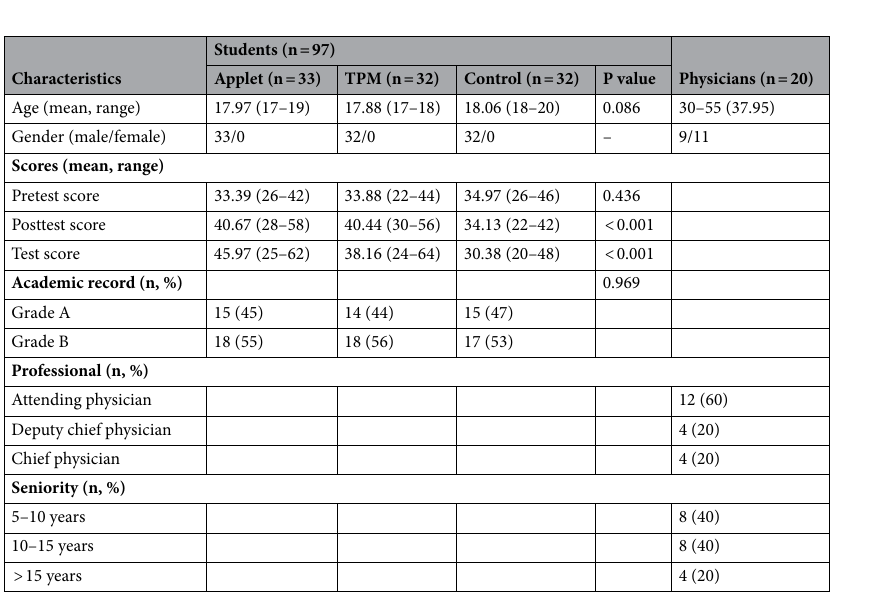
Table 1. Demographic and characteristics of participants. TPM: Traditional paper media; Grade A presents ranking in the top 50% of the grade; Grade B presents ranking at the bottom 50% of the grade.